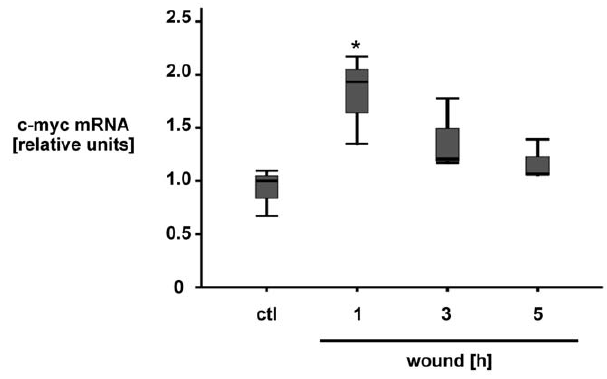
Figure 3. Wounding induces c-myc mRNA accumulation in IEC18 cell monolayers. Rat intestinal epithelial IEC18 cells were grown to confluency in 6-well-plates, serum-starved overnight, and cell monolayers were then wounded by multiple scraping. At the indicated time points, total cell RNA extracts were prepared and analysed for c- myc mRNA accumulation normalized to GAPDH control via real-time RT-PCR using specific primers. mRNA accumulation relative to unwounded control is expressed as median and interquartile range (IQR) of n=3 separate experiments, each with three separate wells per condition. Statistical analysis was performed by the Kruskal-Wallis test for non-parametric data (*p , 0.05 versus control).